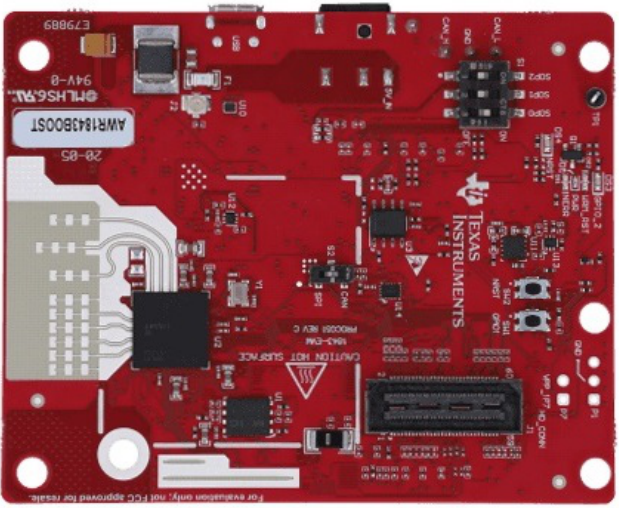
Figure 3. EVM AWR1843BOOST from Texas